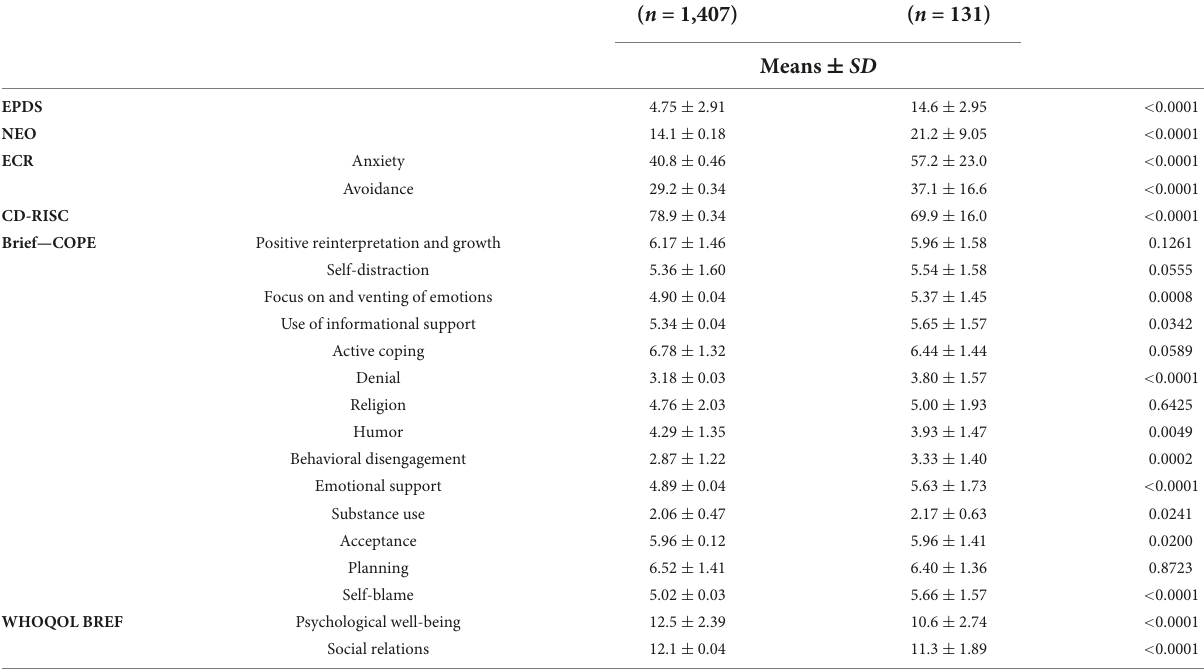
TABLE 7 Comparison of psychological characteristics between women reporting EPDS scores < 12 ( n = 1,407) or ≥ 12 ( n = 131) at T1. Characteristics